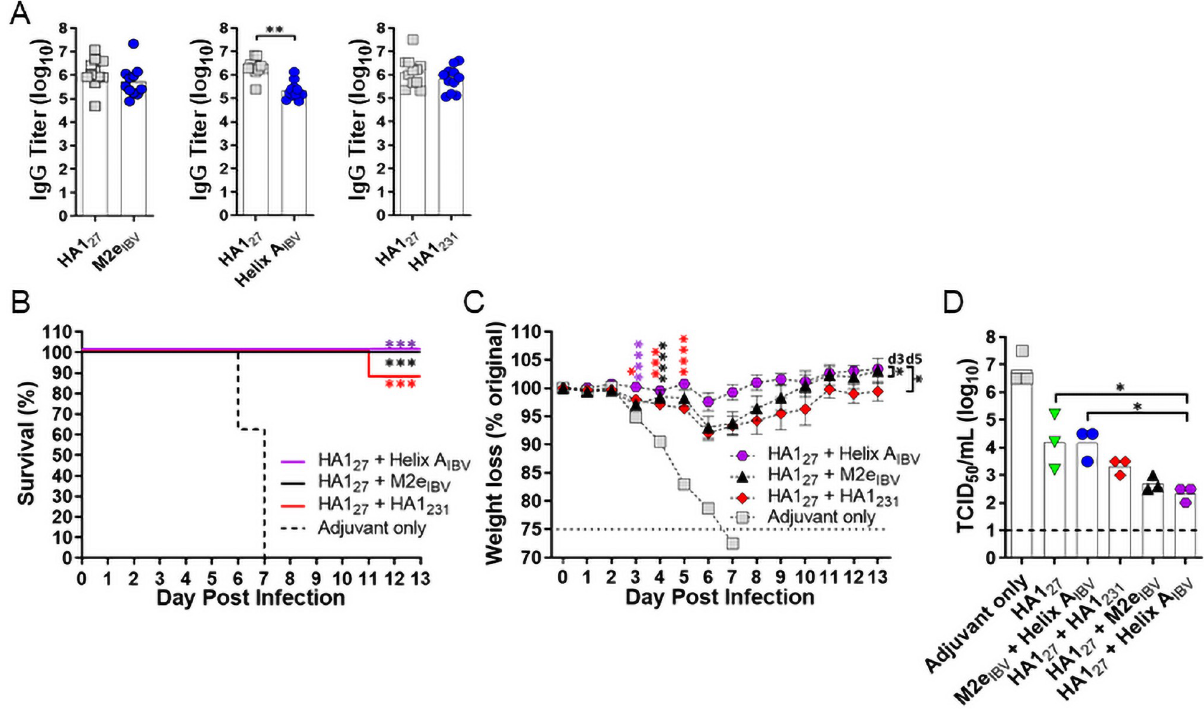
Fig 4. Bivalent HA1 27 -based influenza B vaccines confer strong protection against influenza B challenge. CD-1 mice (n = 11) were immunized with HA1 27 + M2e IAV , HA1 27 + Helix A IBV , and HA1 27 + HA1 231 formulations (10 μ g/peptide) in GLA-SE. ( A ), Day 35 antisera were assayed for titers to each target separately by ELISA. One-way ANOVA followed by Tukey’s multiple comparisons test was used for statistical analysis ( �� P < 0.01). On day 42, mice were challenged with 5LD 50 B/Florida/04/2006 and were monitored for ( B ) survival, ( C ) weight loss plotted as mean ± S.E.M, and ( D ) viral load. Survival curves were compared by log-rank Mantel-Cox test. Data from each weight loss time point were compared by one-way ANOVA followed by Dunnett’s multiple comparisons test. Color coded asterisks without brackets denote significance between control and indicated test group. Brackets indicate comparison between test groups. For weight loss, significance over the control is shown until maximum difference and comparison between test groups was maximum on the designated day ( � P < 0.05, ��� P < 0.001, ���� P < 0.0001). For viral load, lungs were assayed four days after infection for mean tissue culture infectious dose (TCID 50 ), with the limit of detection depicted with dashed line. One-way ANOVA followed by Tukey’s multiple comparisons test was used for statistical analysis ( � P <